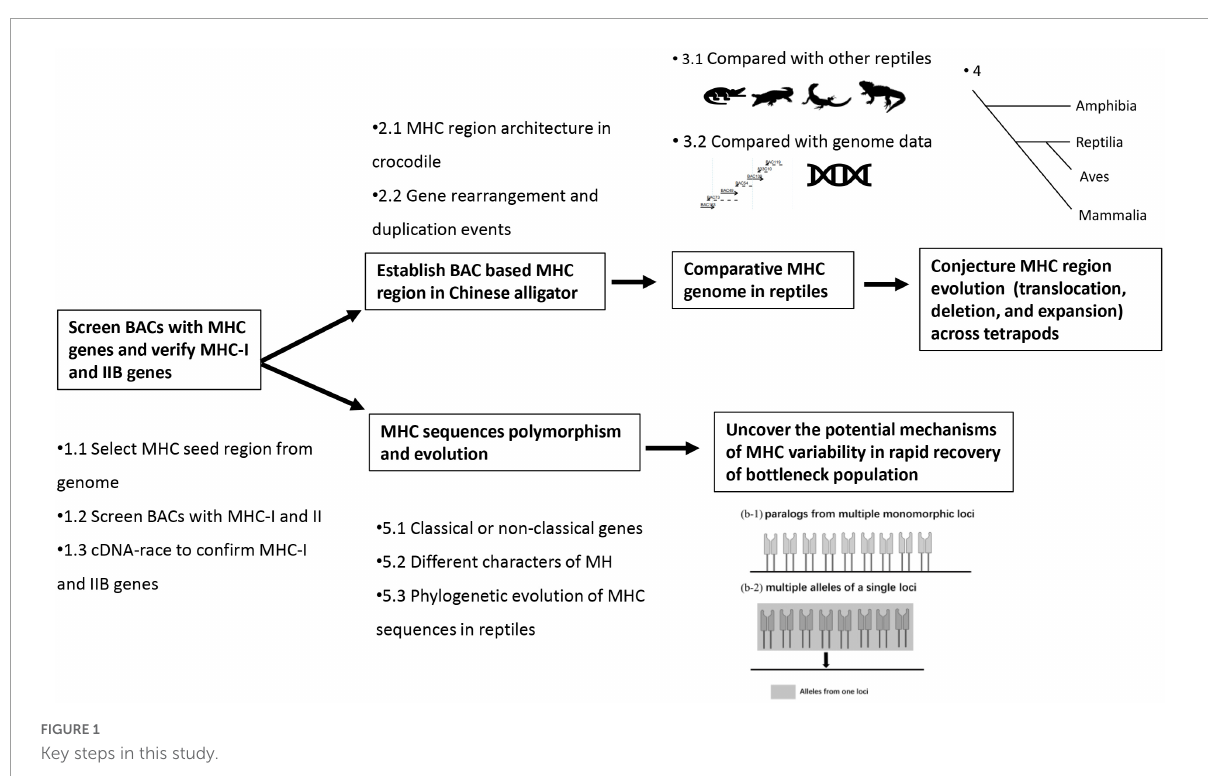
FIGURE1 Key steps in this